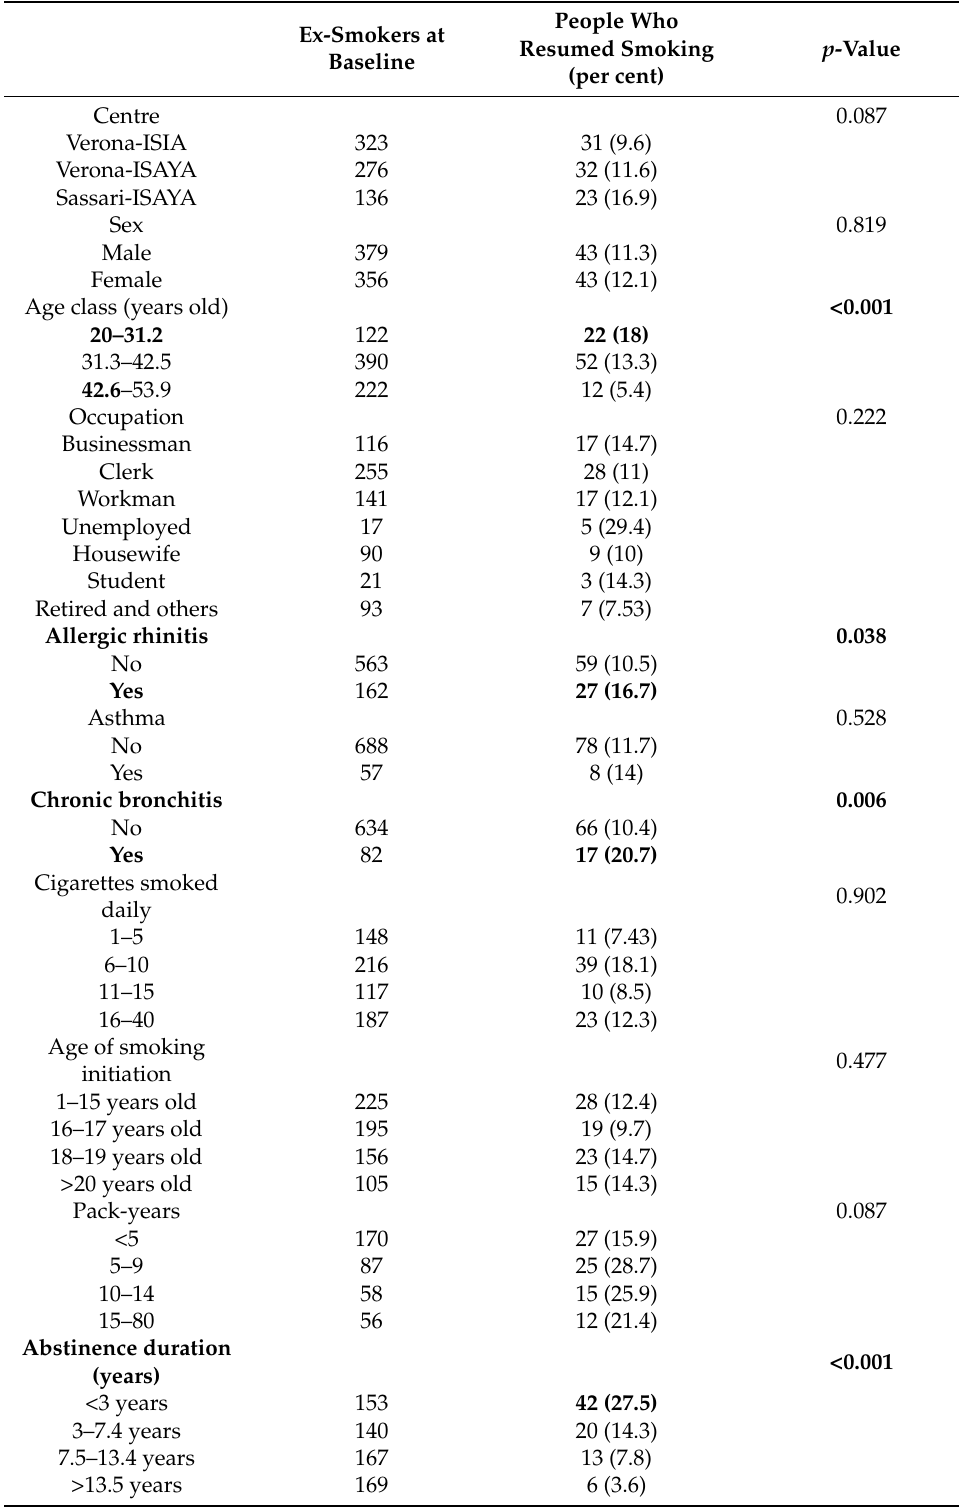
Table 4. Smoking re-initiation in a sample of 735 ex-smokers at